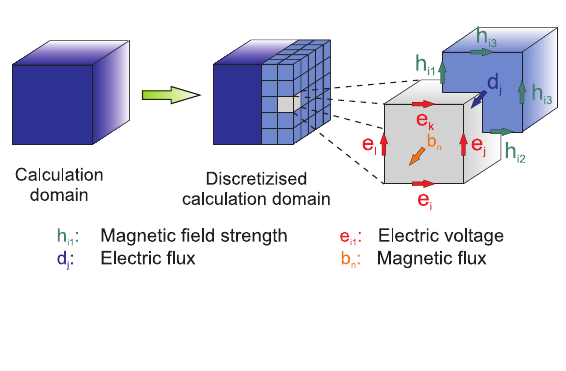
Fig.1: Discretization of electromagnetic properties to a dual FIT grid [25]